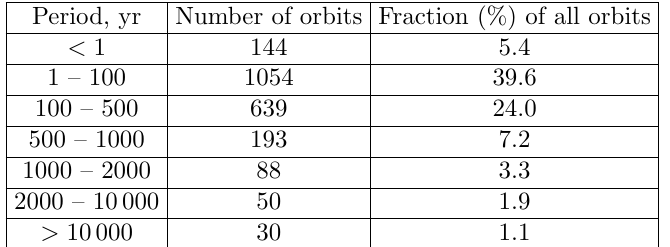
Table 1. Distribution of stars with known orbits by orbital period, based on the ORB6 catalog data. Period, yr Number of orbits Fraction (%) of all